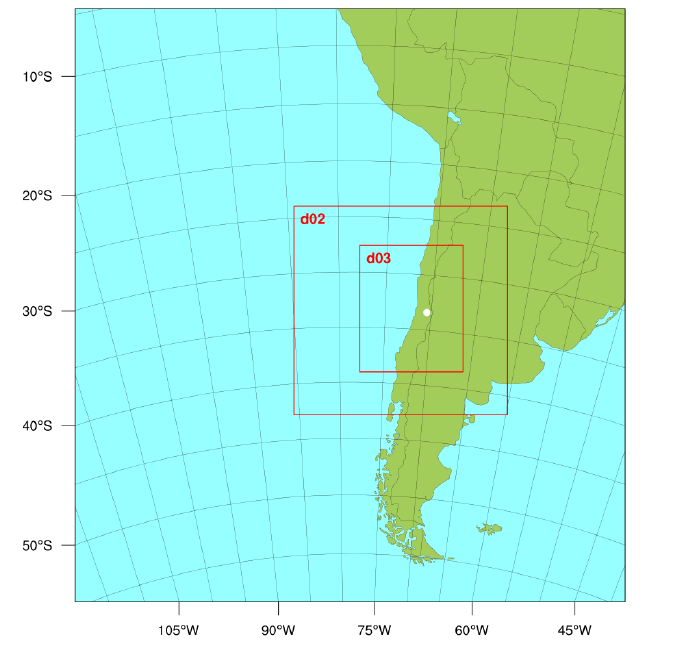
Figure 3. WRF model domains for all the simulations. Domain d01 correspond to the whole plot, and the white point is over Santiago,